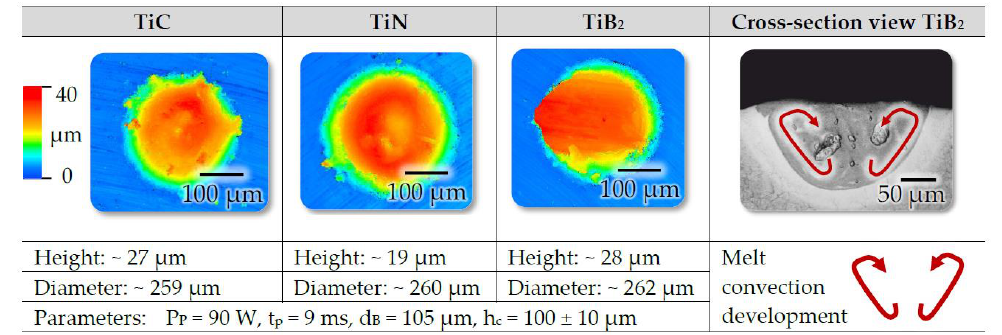
Figure 8. Top view of section II classified microfeatures along with a cross-section image, which illustrates the melt convection developed in the implantation